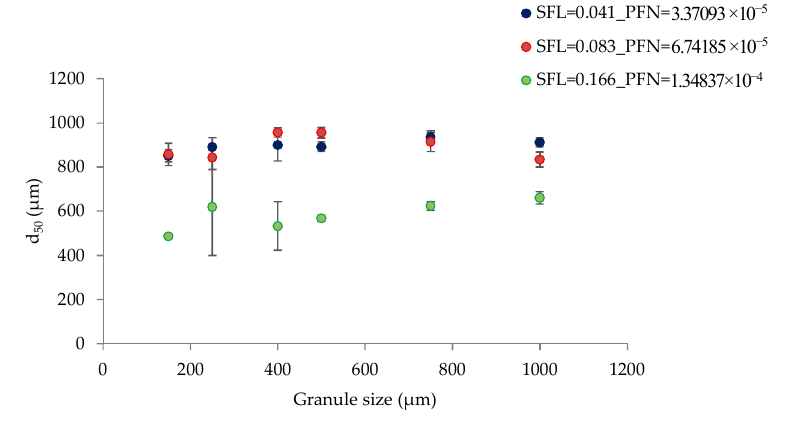
Figure 16. Median granule size of MCC at different SFL–PFN at varying screw speed (L/S 1).